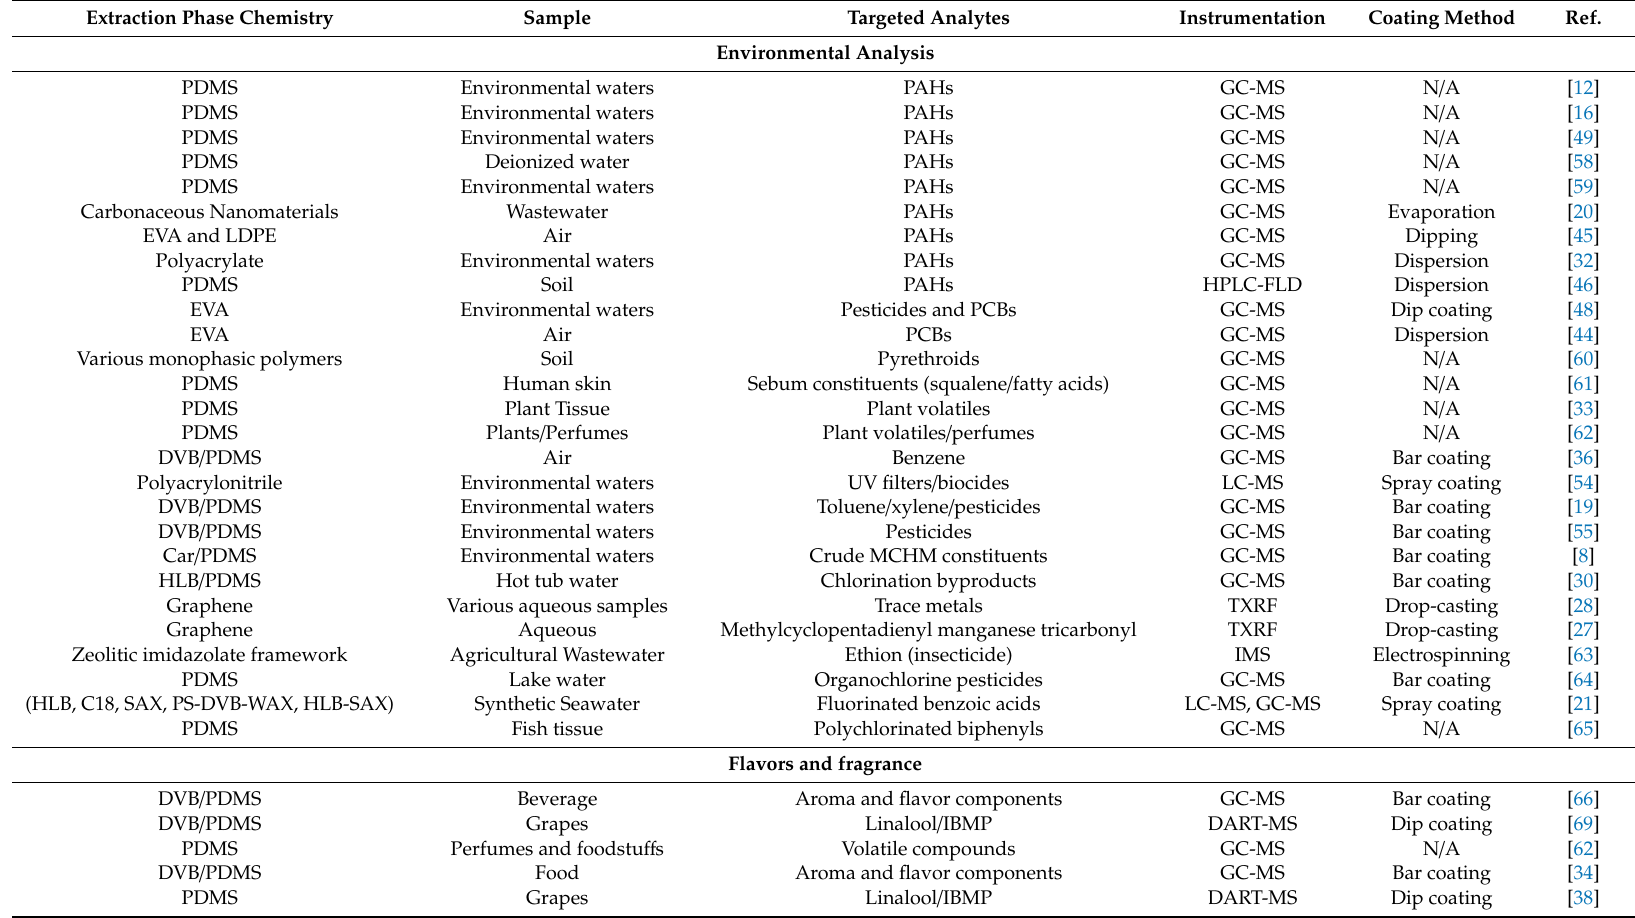
Table 3. Applications of TF-SPME and closely related